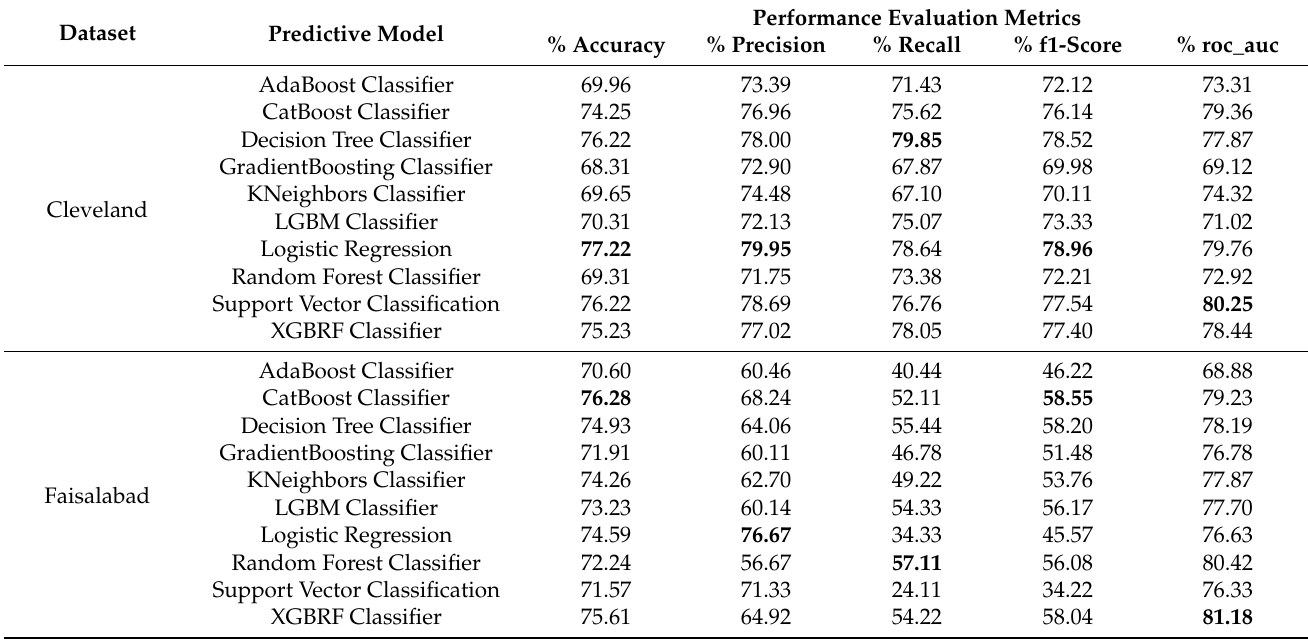
Table 9. K-fold cross-validation performance analysis of ML classifiers on the top-two attributes from the Cleveland and Faisalabad